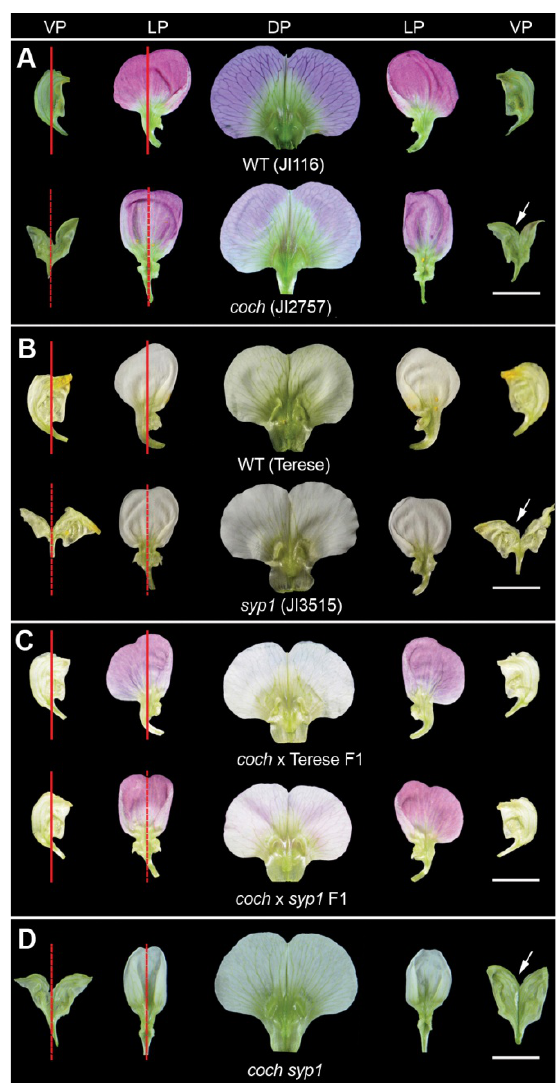
Figure 1. Phenotypes of the cochleata ( coch ) and symmetric petals ( syp1) mutants in pea. ( A ) Petals of the wild type (JI116) and the coch mutant (JI2757) possess dorsal-ventral (DV) differentiation. ( B ) Petals of the wild type (Terese) and the syp1 mutant (JI2757) possess DV differentiation. ( C ) Petals of the F 1 plants ( coch × Terese, coch × syp1 ) possess DV differentiation. ( D ) Petals of the coch syp1 double mutant possess DV differentiation. The red lines indicate the internal (IN) asymmetry and the dotted lines indicate the abolishment of IN asymmetry. The arrows indicate the cutting at the ventral petals so as to flatten the petals. DP, the dorsal petal; LP, the lateral petal; VP, the ventral petal. ( A – D ) Scale bar = 1 cm. In Virus-Induced Gene Silencing (VIGS)- COCH silenced plants [23], 15.46% and 9.28% of